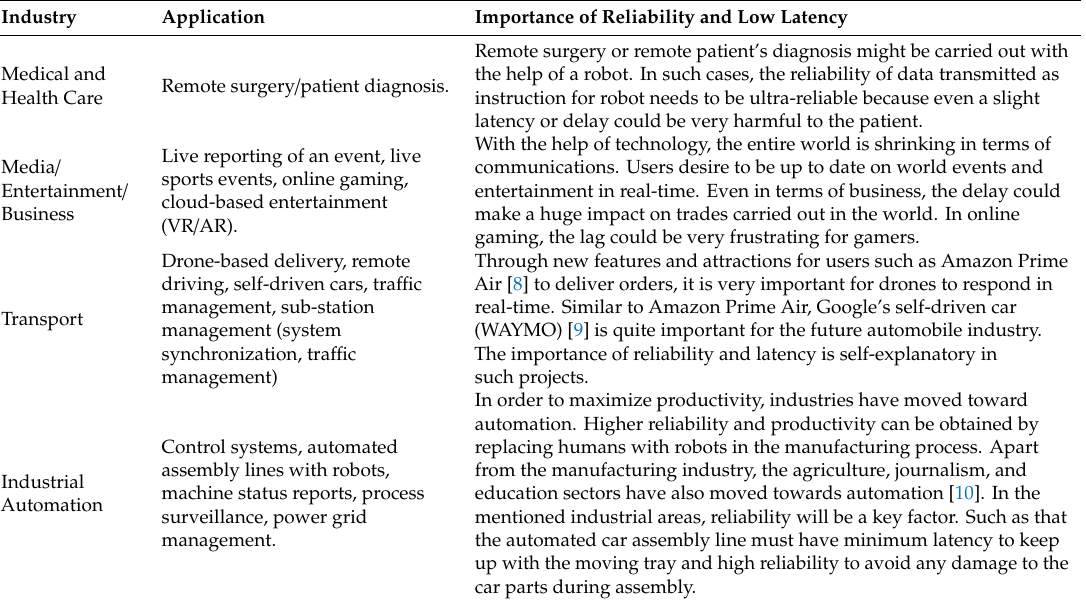
Table 2. Importance of reliability and low-latency as per industrial / user requirements